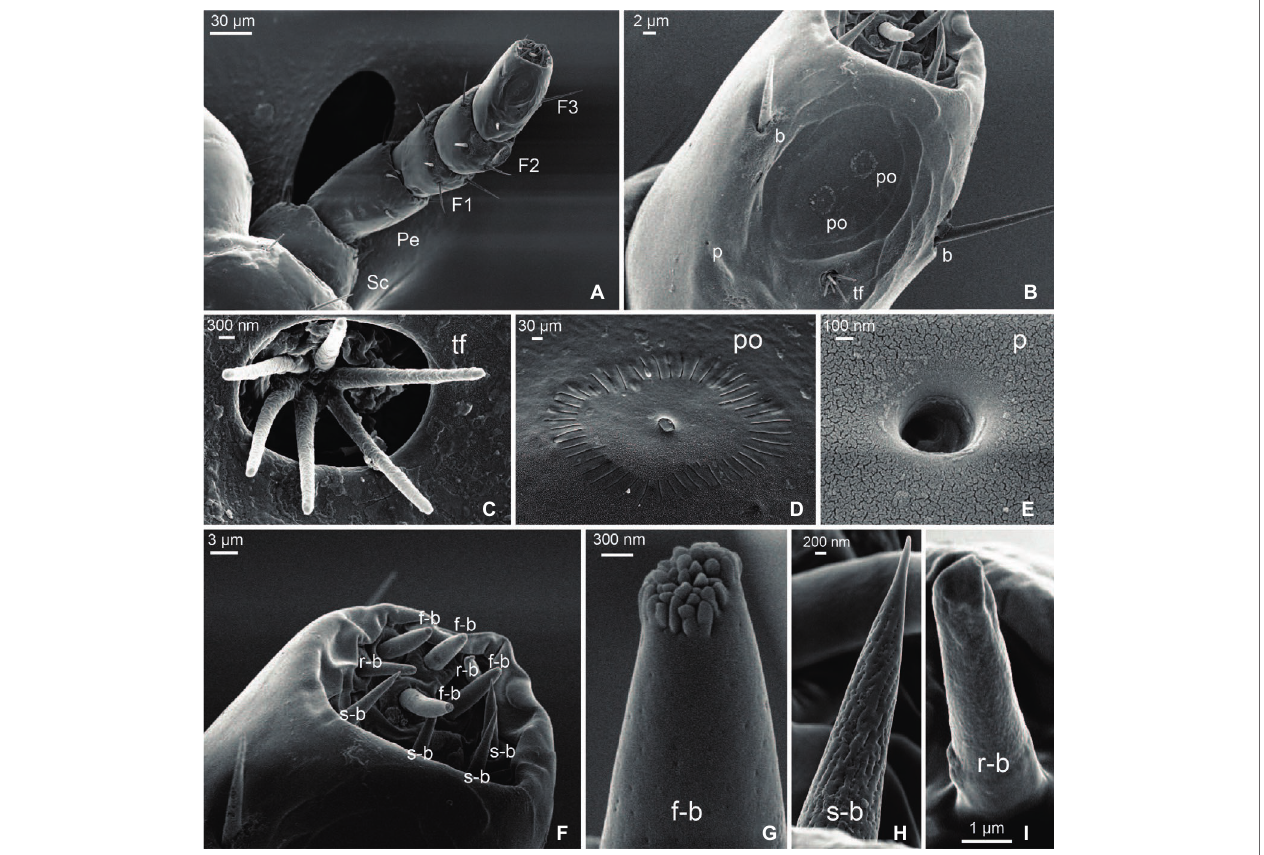
FIGURE 1 | Scanning electron micrographs of the antenna of head lice. (A) General view of the whole antenna constituted by scapus (Sc), pedicellum (Pe), and a composed flagellum with three flagellomeres (F1, F2, and F3). (B) Detail of F3 showing one tuft organ (tf), two pore organs (po), two bristles (b), and one single pore (p). (C) Detail of a tuft organ. (D) Detail of a pore organ. (E) Detail of a single pore. (F) Magnification of the distal end of F3 showing three types of basiconica sensilla: finger-like (f-b), sharp-end (s-b), and round-end (r-b). (G) Detail of a finger-like basiconica sensillum. (H) Detail of a sharp-end basiconica sensillum. (I) Detail of a round-end basiconica